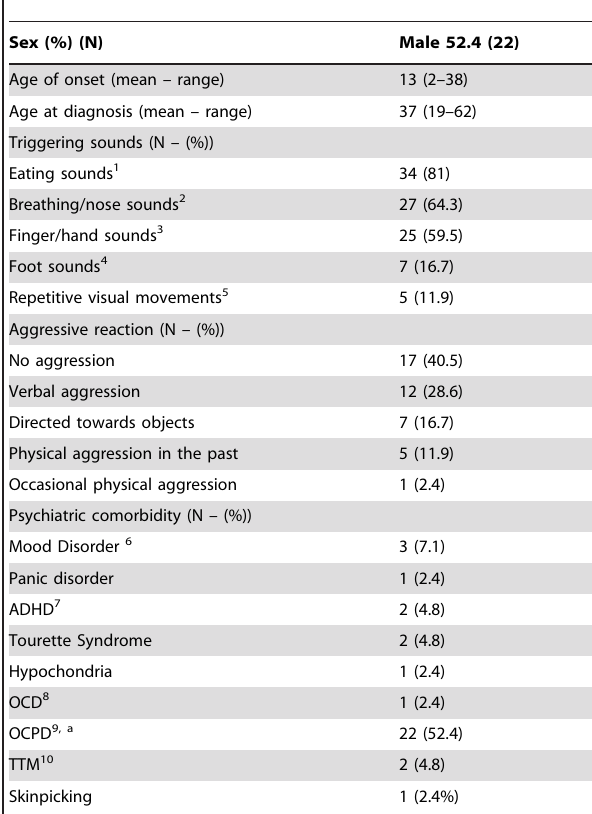
Table 1. Demographic and clinical characteristics of the misophonia patients (N =42).